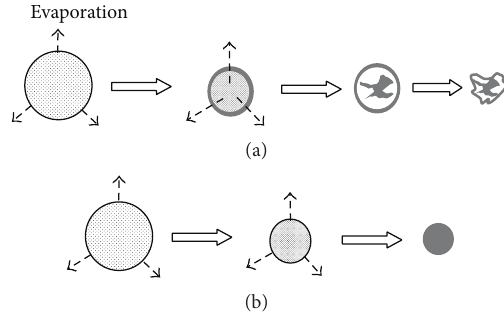
Figure 5: Hypothetical steps during formation of particles during drying:(a)athighdryingratesformationofcrustandevaporationof water from the inner liquid core leads to a deformed particle; (b) for low drying rate and/or lower concentration of the nanosuspension, droplets evaporate uniformly and the spherical particles are